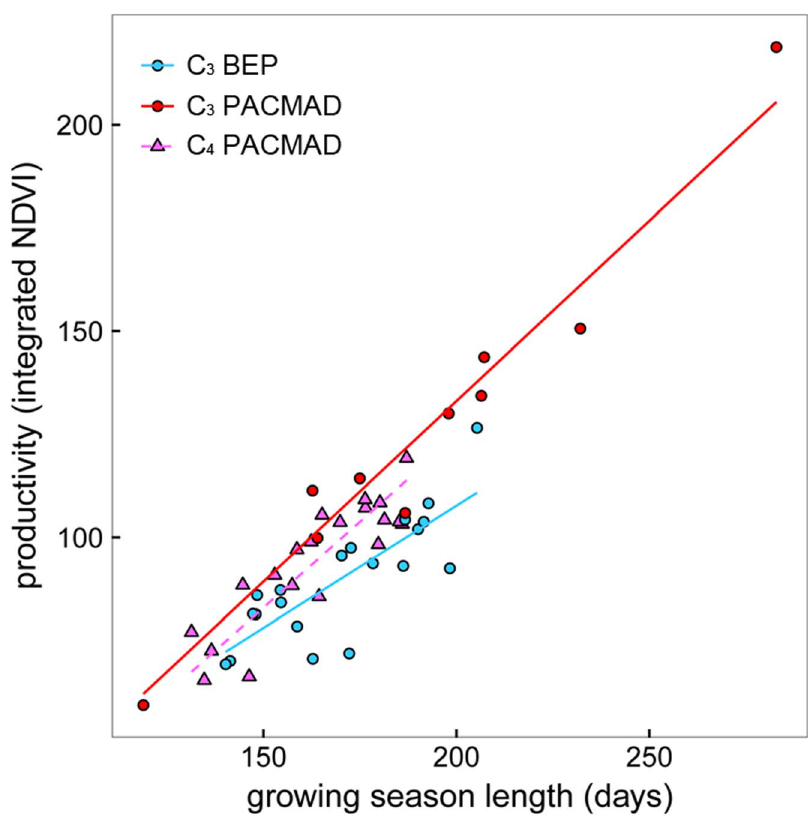
Figure 2. The slope of the relationship between GSL and GSP differed for each photosynthetic type-clade combination (Model D, Table 2). C 3 PACMAD habitats exhibited higher rates of greenness than C 4 PACMAD or C 3 BEP habitats for a given growing season length (slope coefficients=0.87, 0.83, and 0.59 respectively). Differences within the C 3 functional group were larger than between photosynthetic pathways, i.e., there was a larger clade effect than photosynthetic pathway.